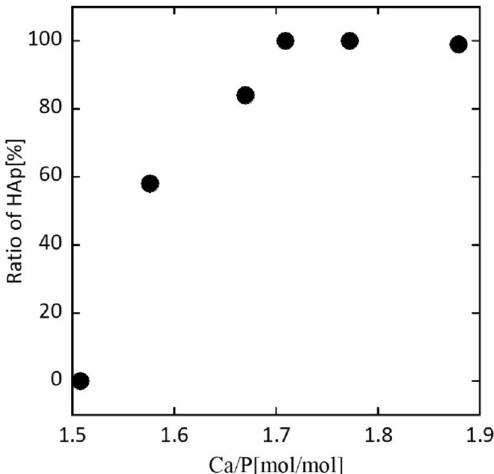
Figure 4. HAp/β-TCP ratio as a function of the Ca/P ratio calculated by the RIR method. Ratio = 0% denotes the crystalline phase is β-TCP. Excess amount of Ca (Ca/P = 1.88) includes 0.6% calcium oxide due to the unreacted ACC.